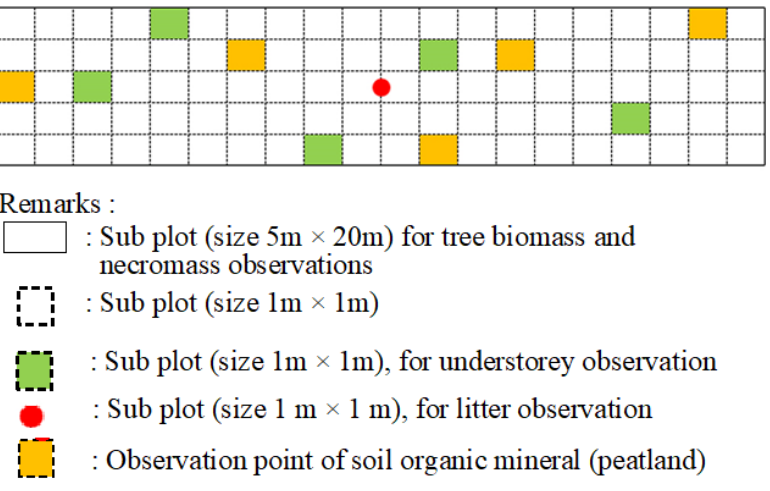
Figure 3. Example of distribution of random sampling points.